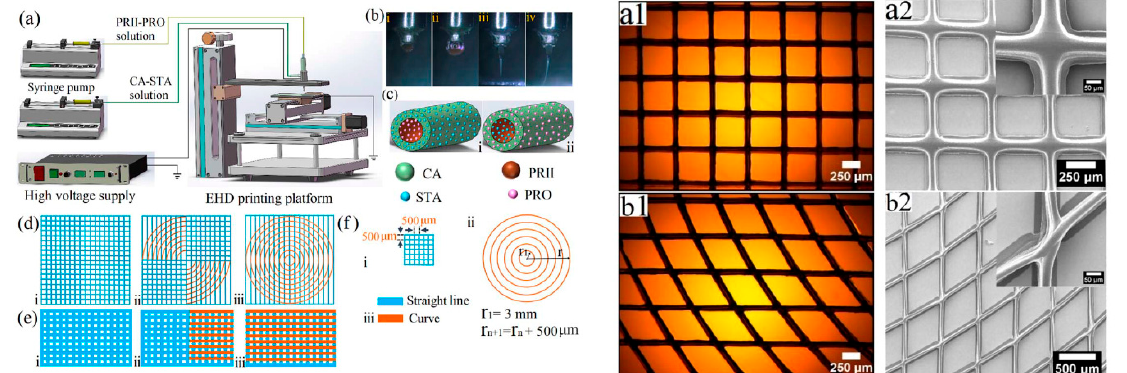
Figure 8. Left: ( a ) Schematic diagram of core-shell electrohydrodynamic 3D printing system; ( b ) Forming process of continuous core-shell stable-jet mode at different voltages: (i) 0 kV, (ii) 1 kV, (iii) 2.5 kV (front view), and (iv) 2.5 kV (side view), (printing: 20 mm/s); ( c ) schematic illustration of the core-shell fibers, CA (cellulose acetate), PRII (polyacrylic resin), STA (stachyose), PRO (proteoglycan); ( d ) top view of patterned fibrous membrane with various geometries—(i) square, (ii) semi-circle, (iii) whole-circle; ( e ) front view of the patterned membrane corresponding to i, ii, and iii of ( d ); ( f ) membrane characteristics—(i) space between two printed fibers; (ii) radius of curves, and (iii) printed fiber with straight and/or curved line. Right: Indicative optical images ( a1 , b1 ) and scanning electron images ( a2 , b2 ) of printed fibers loaded with STA and PRO with various patterns—( a1 , a2 ), square; ( b1 , b2 ), semi-circle. Reprinted from [111], Biofabrication 2020.